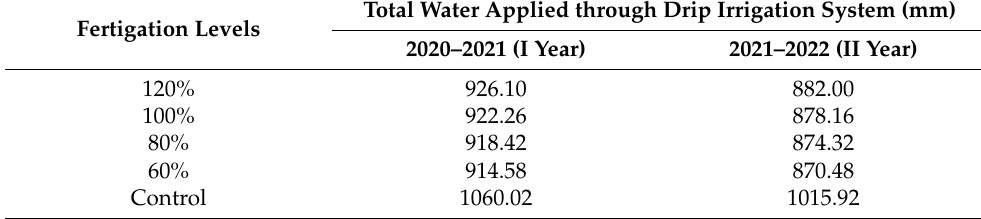
Table 2. Irrigation water applied (mm) in the years 2020–2021 and 2021–2022 during the tomato growth period in naturally ventilated